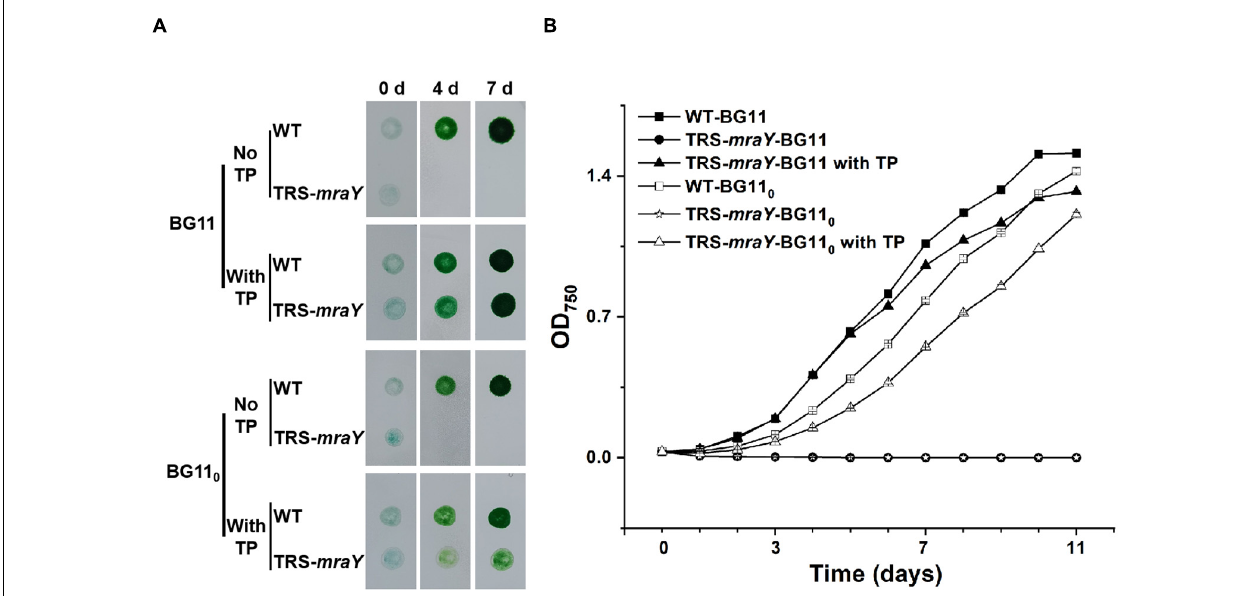
FIGURE 2 | The growth of TRS- mraY in the BG11 and BG11 0 media, under permissive and non-permissive conditions. (A) Anabaena WT and TRS- mraY in the BG11 and BG11 0 on agar plates supplemented with 1 mM of theophylline (With TP) or without TP (No TP). Similar volume of precultures of TRS- mraY or WT at OD 750 0.5 was spotted on agar plates, which were photographed after the indicated time (in days) of incubation. (B) Growth curves of TRS- mraY and WT in BG11 and BG11 0 . Absorbance at 750 nm was measured daily as indicated following inoculation in the BG11 and BG11 0 liquid media supplemented with 1 mM of TP or without TP.